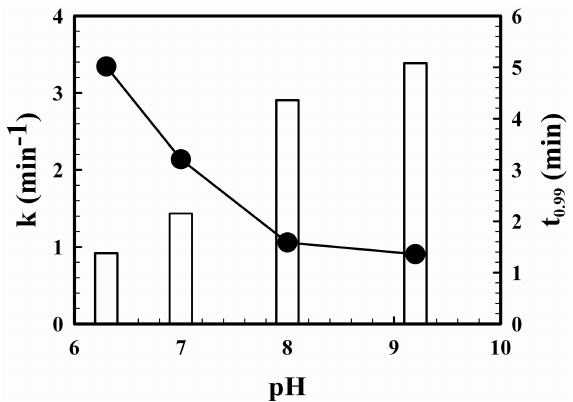
Figure 3. The effect of pH on the rate of the reaction between hydrogen peroxide and scopoletin. : first order rate constant (left axis); bars: time needed for the reaction to reach 99% completion. k: first order rate constant; t 0.99 : time needed for the reaction to reach 99%